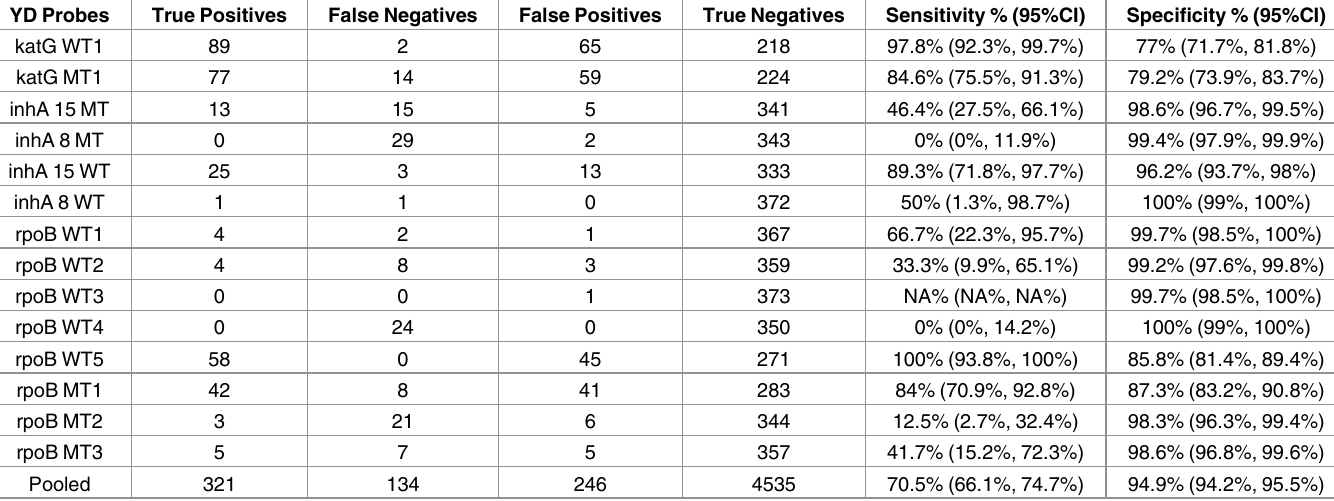
Table 4. Phase 1 per-probe performance analysis on characterized strains.